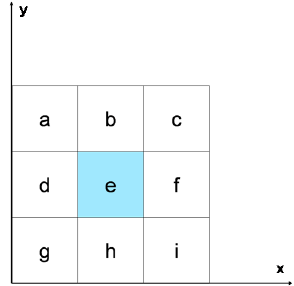
Fig. 3. Calculation of the horizontal and vertical gradient at grid cell e , using the elevation values of the centre cell e and its eight Fig. 3: Calculation of the horizontal and vertical gradient at neighbours. Gradients are calculated for each grid cell in the input grid cell e , using the elevation values of the center cell e and raster using a 3 × 3 itseight neighbors.Gradientsare calculatedforeach gridcell in the input raster using a 3 x 3 window.